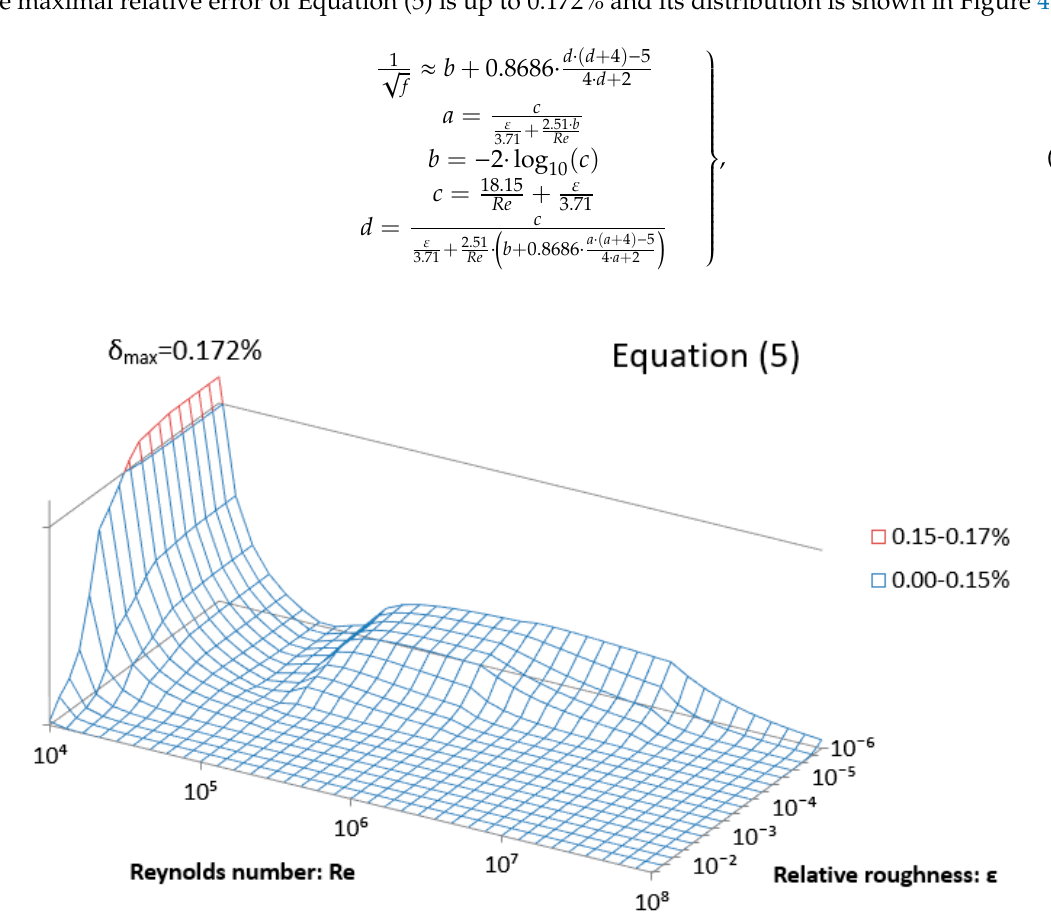
Figure 4. Distribution of the relative error for the approximation with two internal cycles and a fixed starting point.